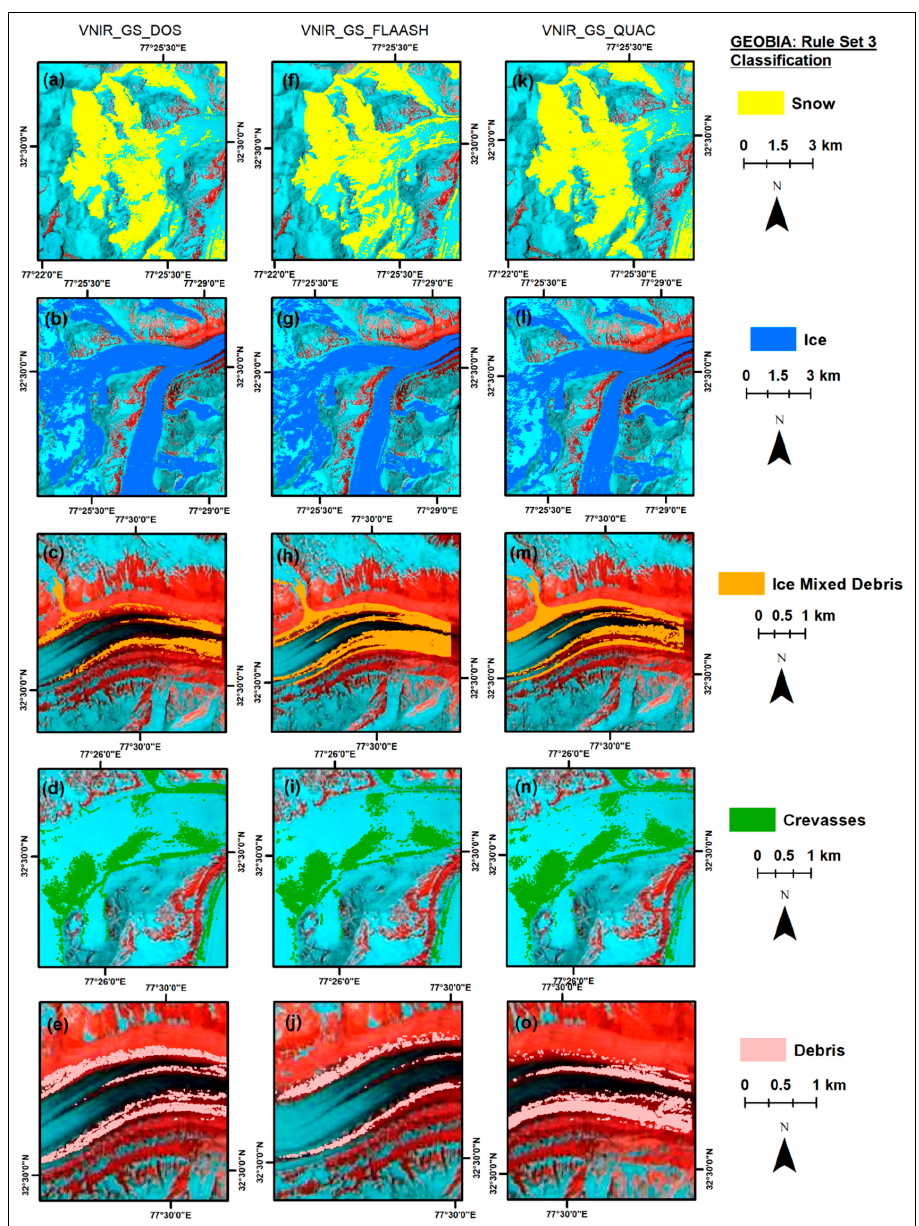
Figure 7. VNIR_GEOBIA_Rule Set 3 classifications of surface facies of the Samudra Tapu glacier. Background image: WorldView-2 © 2014 Maxar. Subfigures ( a – e ) correspond to the snow, ice, ice mixed debris, crevasses, and debris classified from the VNIR_GS_DOS processing scheme. Subfig- ures ( f – j ) correspond to the snow, ice, ice mixed debris, crevasses, and debris classified from the VNIR_GS_FLAASH processing scheme. Subfigures ( k – o ) correspond to the snow, ice, ice mixed debris, crevasses, and debris classified from the VNIR_GS_QUAC processing scheme.